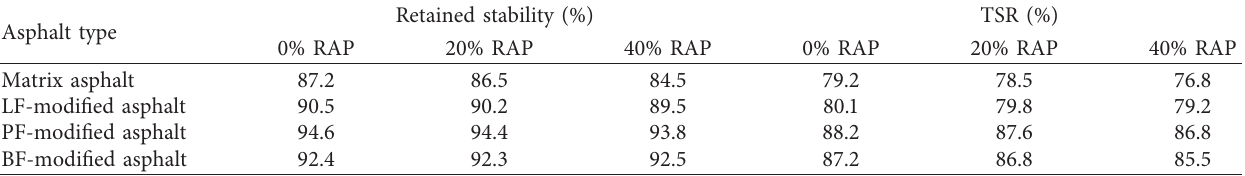
Table 8: Retained stability and TSR results of different asphalt mixtures.